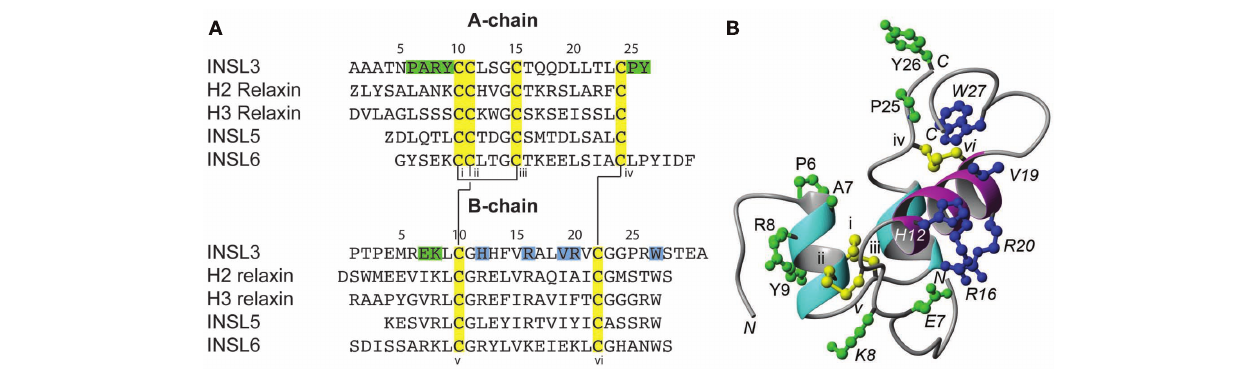
FIGURE 1 | Sequences and three dimensional structure of relaxin peptides. (A) Sequences of the A- and B-chains of INSL3 and selected related members of the relaxin peptide family. (B) Solution NMR structure of INSL3 illustrating the typical overall fold of relaxins.The helical segments of the A-chain are shown in cyan and the single helical segment of the B-chain is shown in magenta.The conserved cysteine residues forming three disulfide